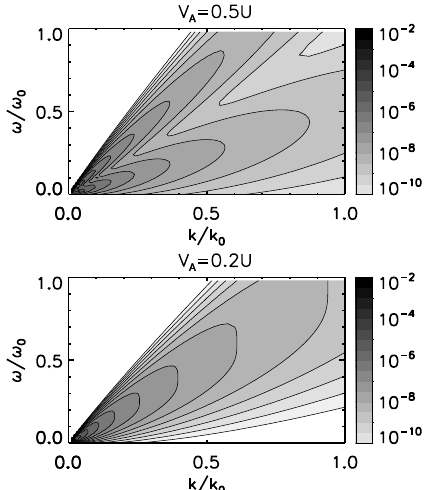
Figure 2. Wavenumber–frequency spectra with strong splitting (up- per panel) and weak splitting (lower panel) for magnetohydrody- namic